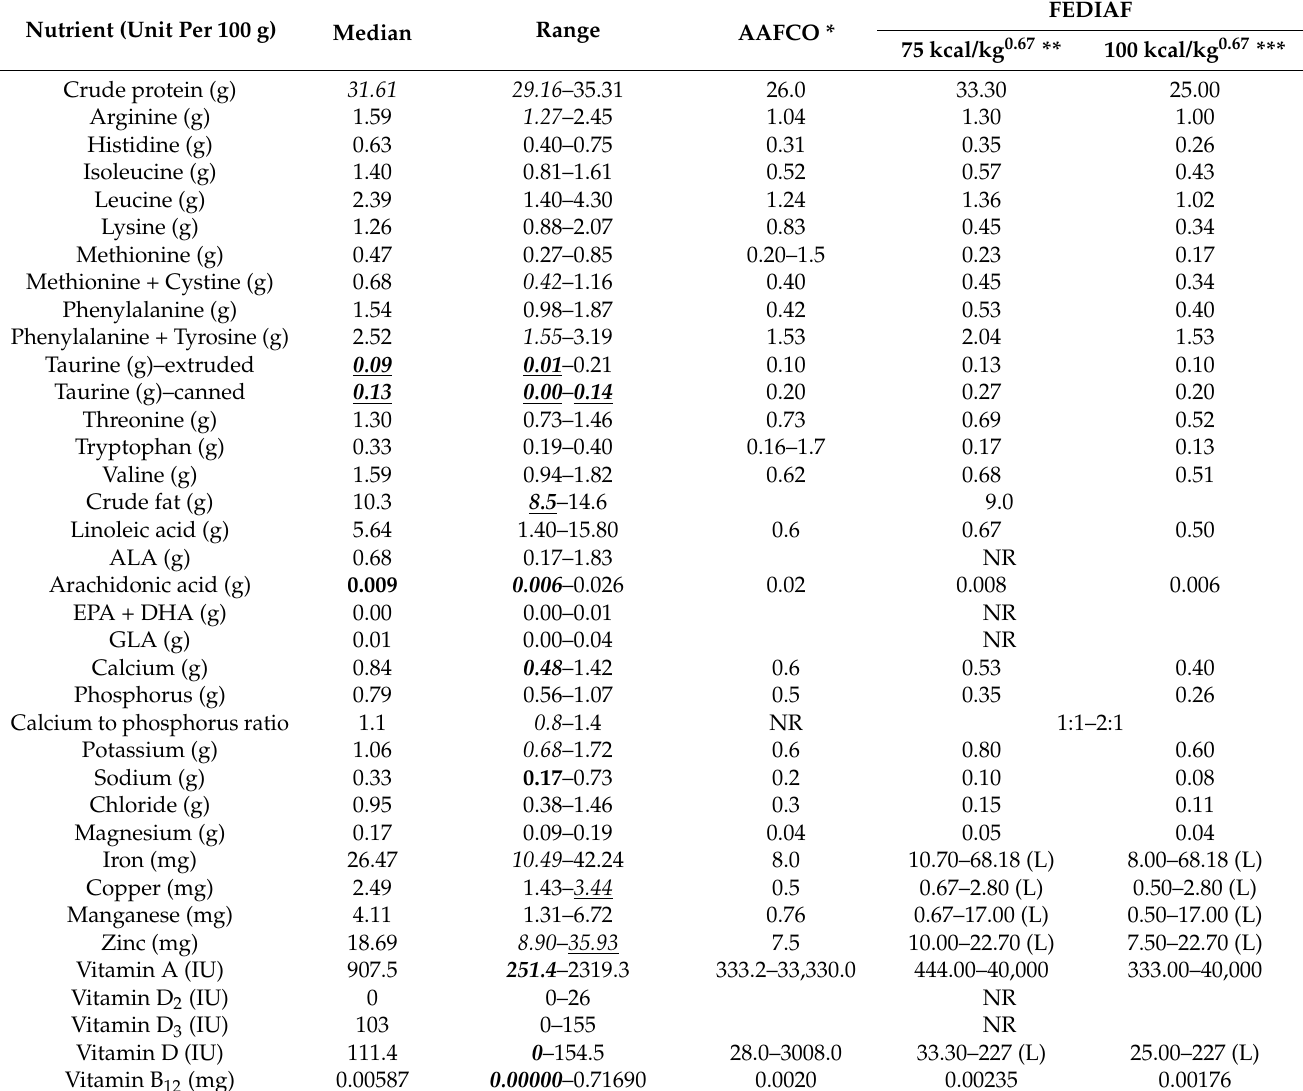
Table 3. Measured nutrient content in eight plant-based feline foods commercially available in Canada and labeled for adult or all life stage compared to the AAFCO and FEDIAF recommended essential nutrient concentrations for feline adult maintenance on a dry matter basis (unit per 100 g dry